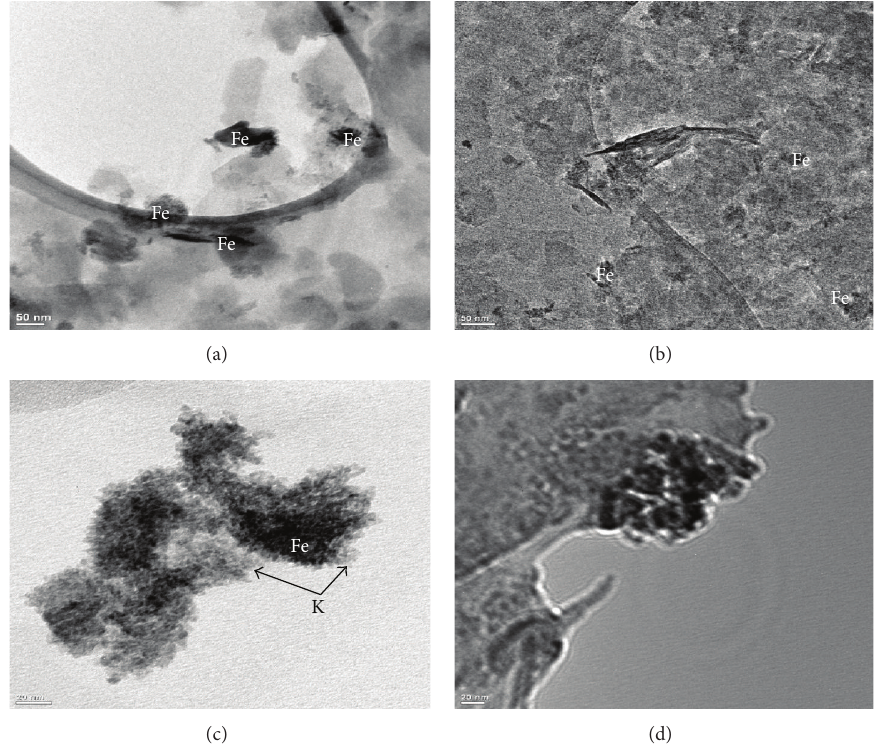
Figure 2: TEM images of (a) smectitic nanocolloids with interbedded iron minerals (Fe), (b) mixed mineralogy nanocolloid aggregates showing HIV/vermiculite and interbedded iron minerals (Fe), (c) an aggregate of small hexagonally shaped kaolinitic particles with interbedded iron (Fe), and (d) a biosolid nanocolloid aggregate (mineralogy as verified by morphology and XRD/TG analysis).